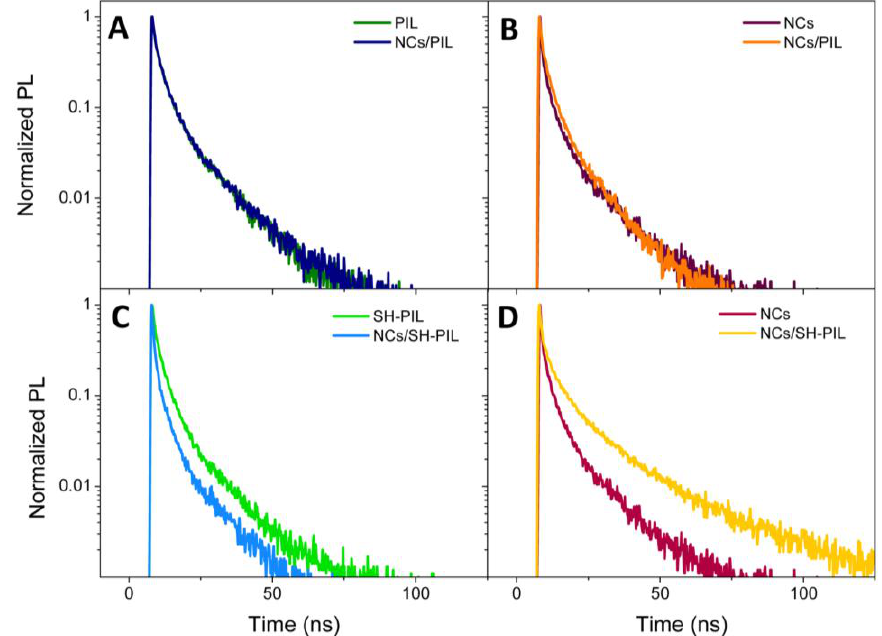
Figure 4. Normalized TR-PL emission decay of the NCs/PIL nanocomposite DMSO dispersion compared with the bare components, at the ( A ) PIL and ( B ) NC maximum emission wavelengths. The normalized TR-PL emission decay of the NCs/SH-PIL nanocomposite DMSO dispersion compared with the bare components, at the ( C ) SH-PIL and ( D ) NC maximum emission